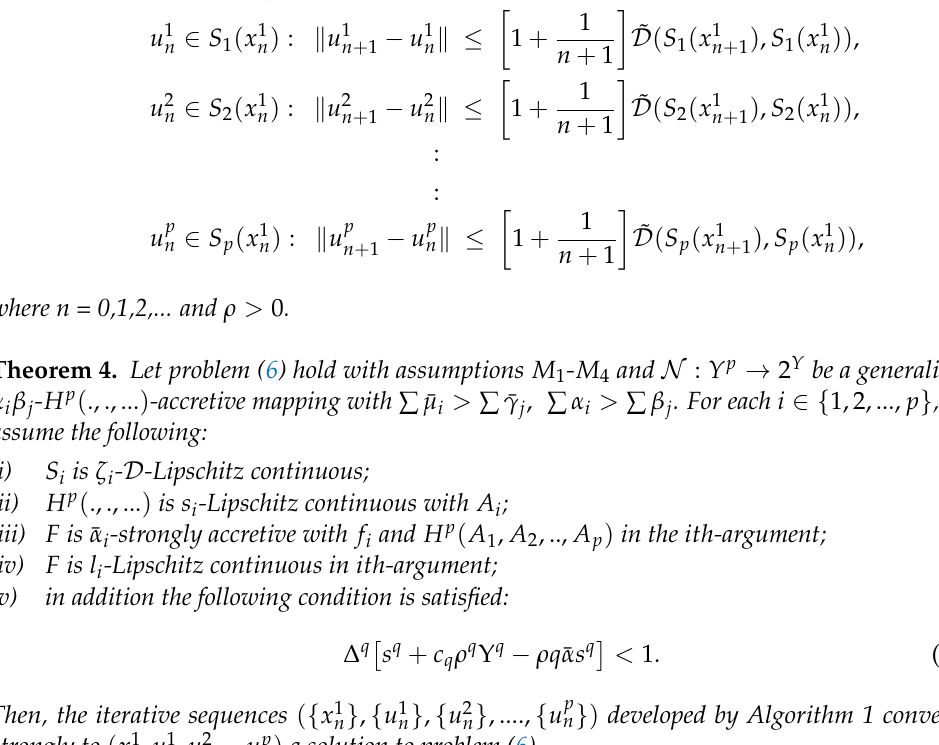
∈ S ( x 1 ) , u 2 ∈ S ( x 1 ) , ..., u p 2 1 0 0 0 0